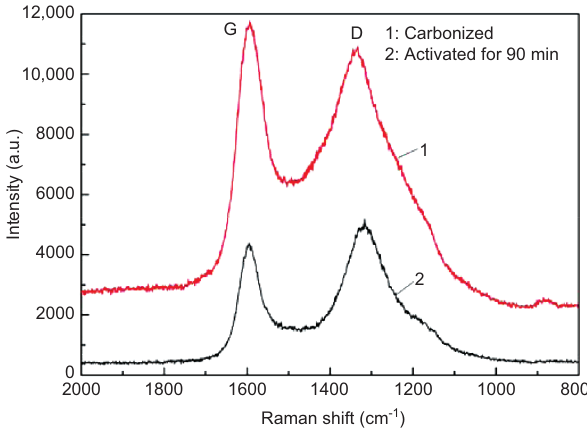
Figure 6 Raman spectrum of the 30 wt.% CNTs/AC composite